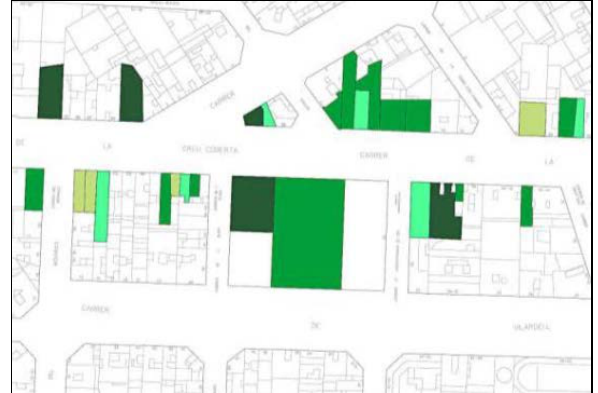
Figure 3. Example of individual building accessibility map with dark green representing accessible buildings, clear green representing not accessible buildings and difficult to solve and intermediate greens representing not accessible buildings but easily solvable (Source: Bestraten, 2015).